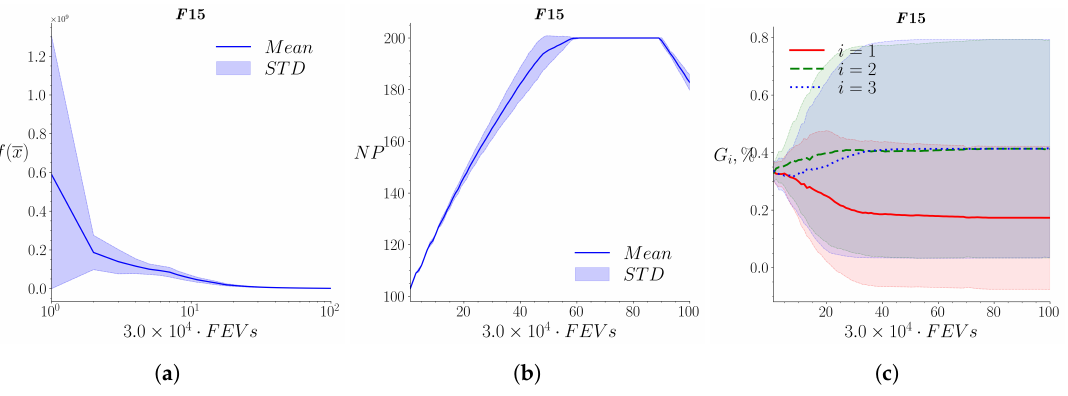
Figure A15. The dynamics of COSACC-LS1 on the F15 problem: ( a ) Convergence; ( b ) Population size; ( c ) Redistribution of